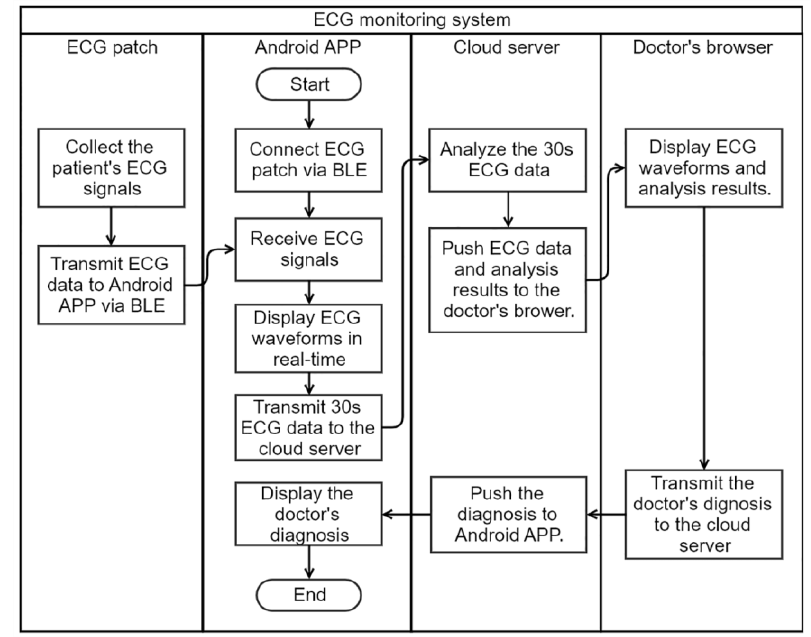
Figure 2. Flow chart of the proposed ECG monitoring System.